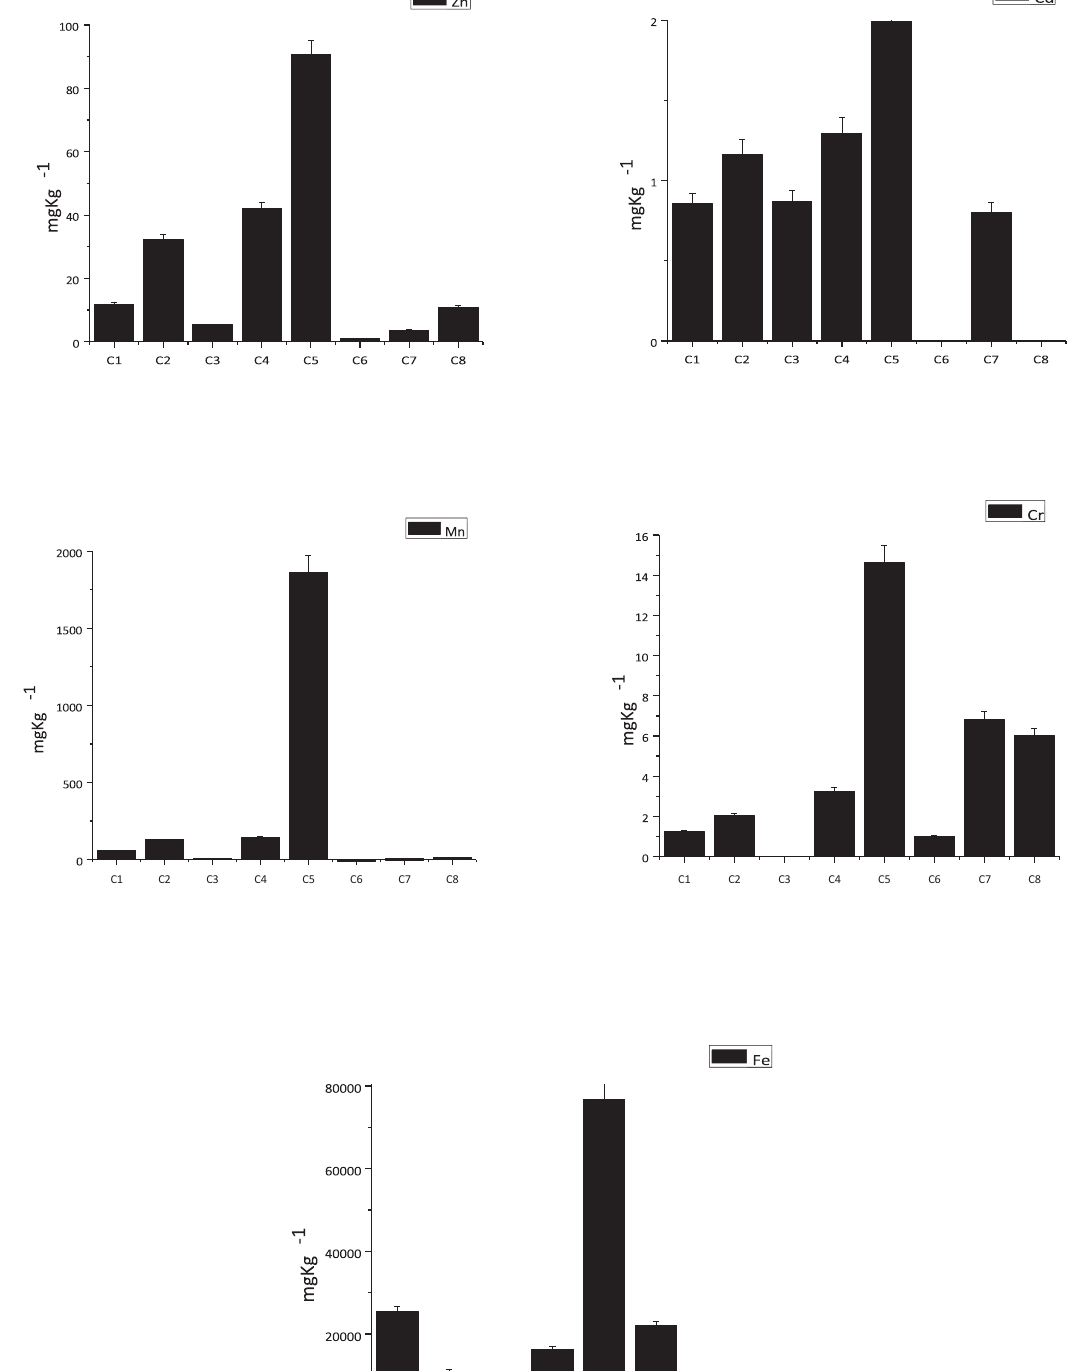
Figure 2 - Mean values and standard deviation of actual metal concentrations (2016) determined in sediments from the eight sampling sites. Streams C1 to C5 are located in sugarcane cultivation areas. Strems C6 to C8 are located in preserved areas. Streams detailed information in Table